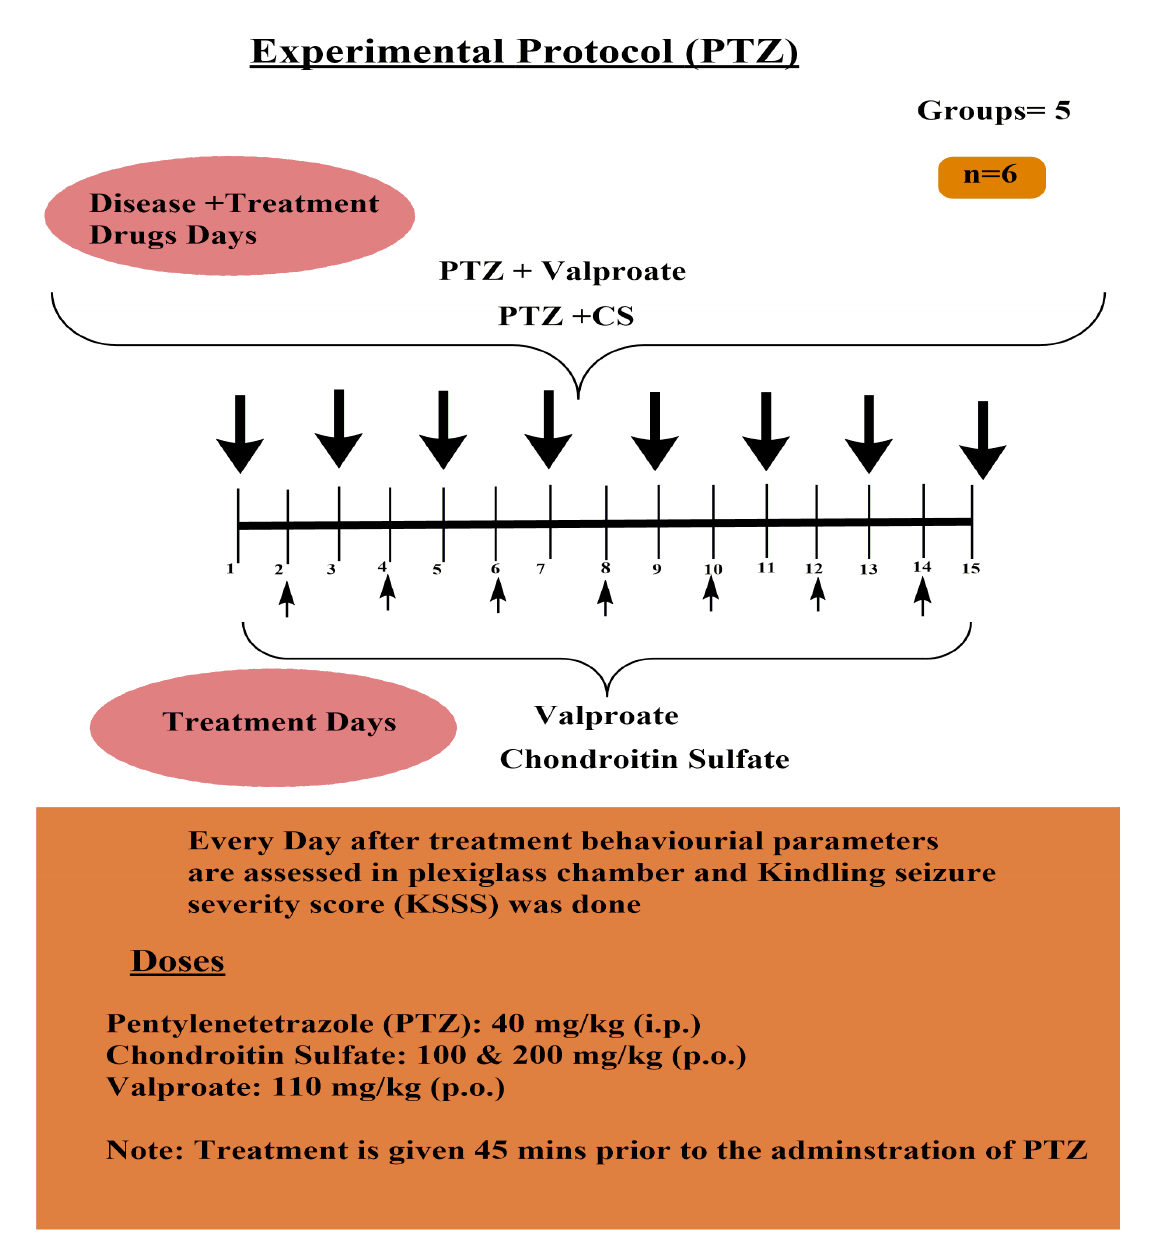
Figure 1. Experimental protocol for pentylenetetrazole-induced kindled seizure severity score assessment protocol.